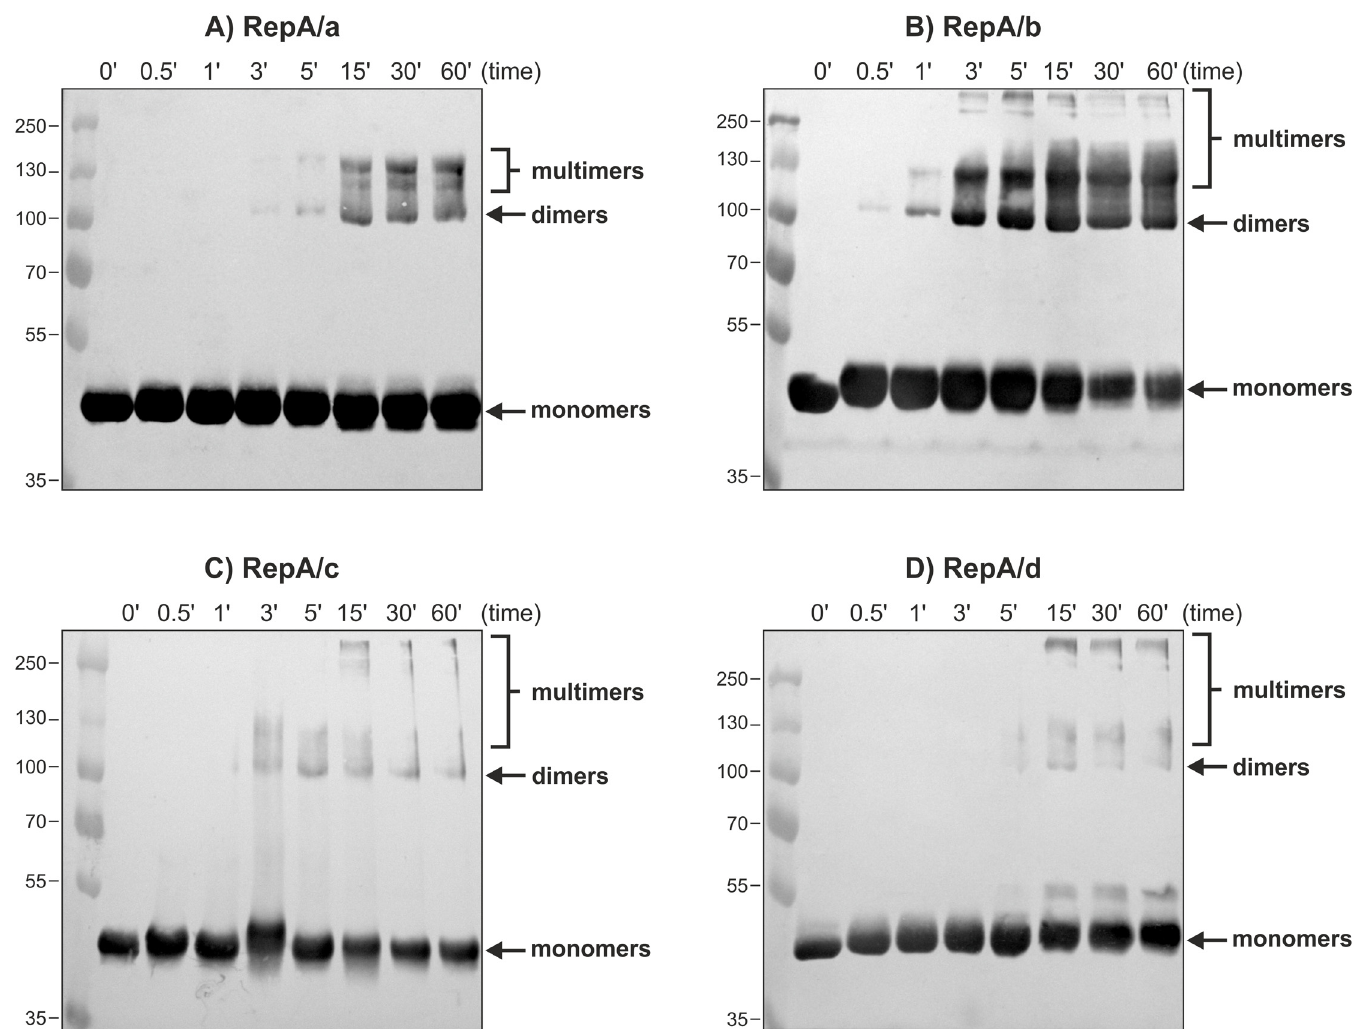
Fig 7. Time course cross-linking analysis of His 6 -RepA/a-d. His 6 -tagged RepA proteins (0.1 – 0.2 nM) were incubated with DMP concentration fixed at 10 mM, at 28°C, from 30 s to 120 min, separated on 10% SDS-PAGE and visualized by Western blot with anti-His 6 antibodies. The thin lines indicate the marker bands whose molecular masses are expressed in kDa. Arrows indicate different species formed by RepA proteins corresponding to monomers and dimers, while the position of multimers was marked with